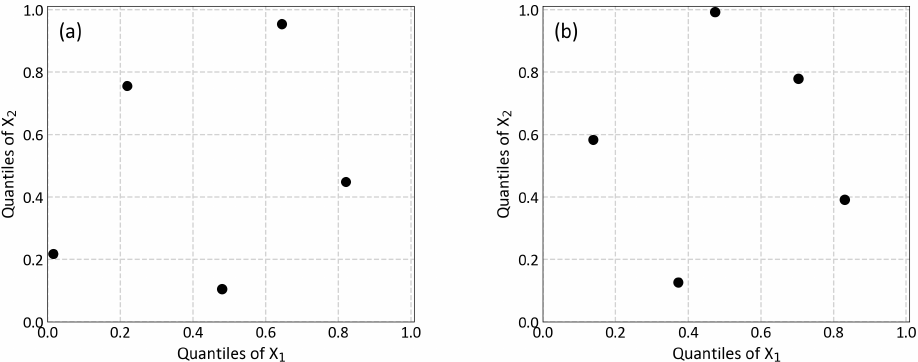
Figure 3. A sampling design with n = 5 realizations generated by ( a ) maximin LHS and ( b ) LHSMDU in a two-dimensional sampling space where the random variables are